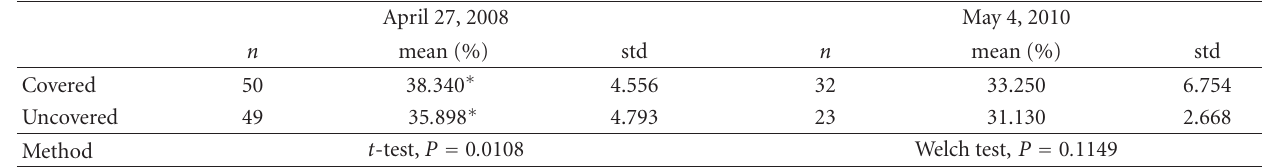
Table 4: The e ff ect of flower isolation on nectar concentration at site 3.